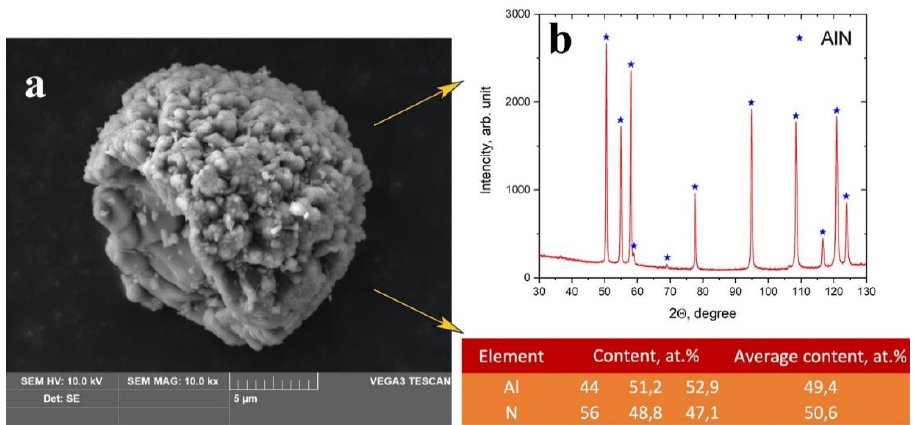
Figure 3. SEM of separate AlN particle ( a ), X-Ray diffraction pattern ( b ), and table with elemental composition analyzed by EDX analysis.